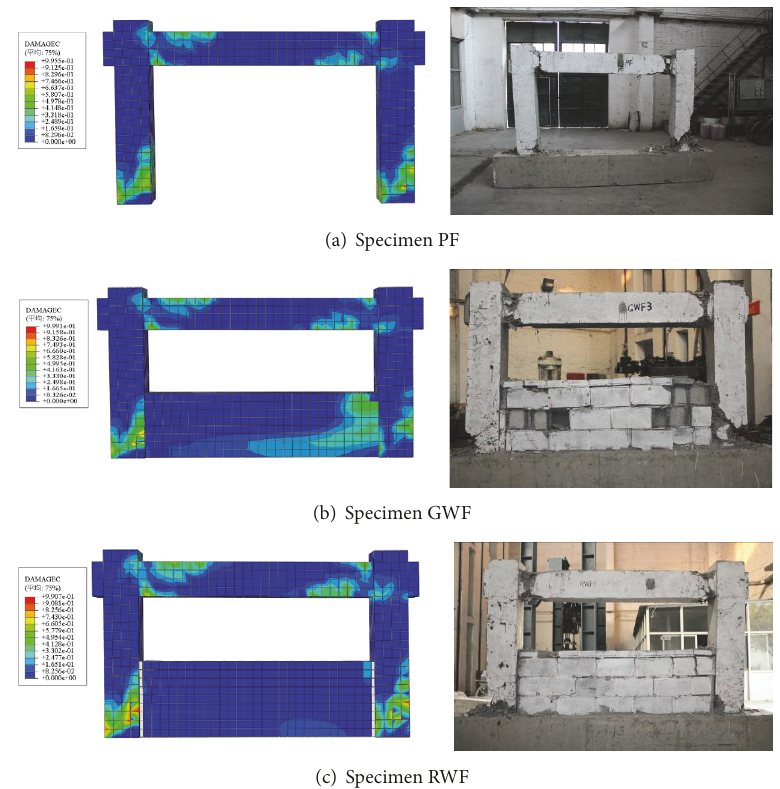
Figure 14: Plastic damage in compression from modeling and failure phenomenon from experiment.